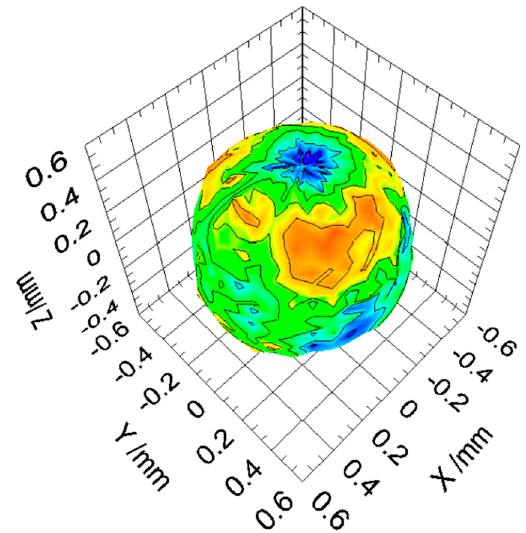
Figure 6. Sphericity map of a 1 mm ruby sphere with 33 nm form deviation. The 3D plot shows results obtained by probing the surface with a 10° resolution in longitude and a 5° resolution in latitude.